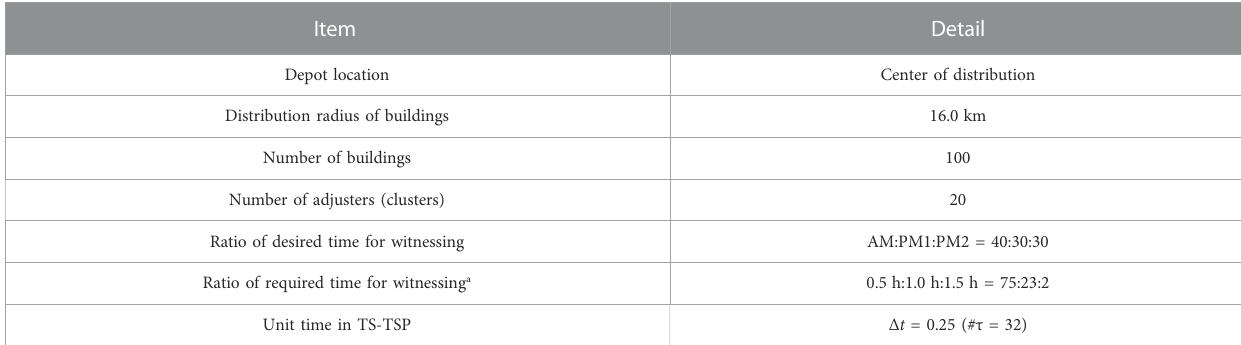
TABLE 2 Settings for each instance in the base